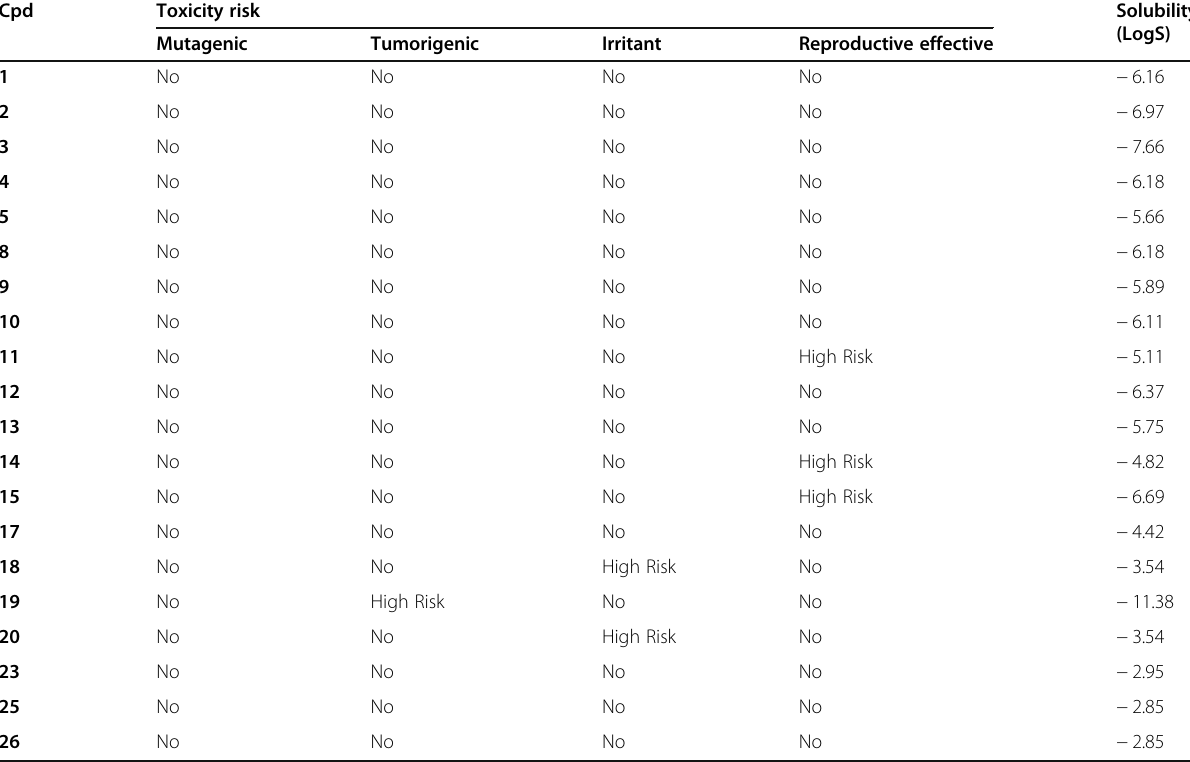
Table 6 Toxicity risks of top, multi-targeting compounds as predicted by OSIRIS Property Explorer Cpd Toxicity